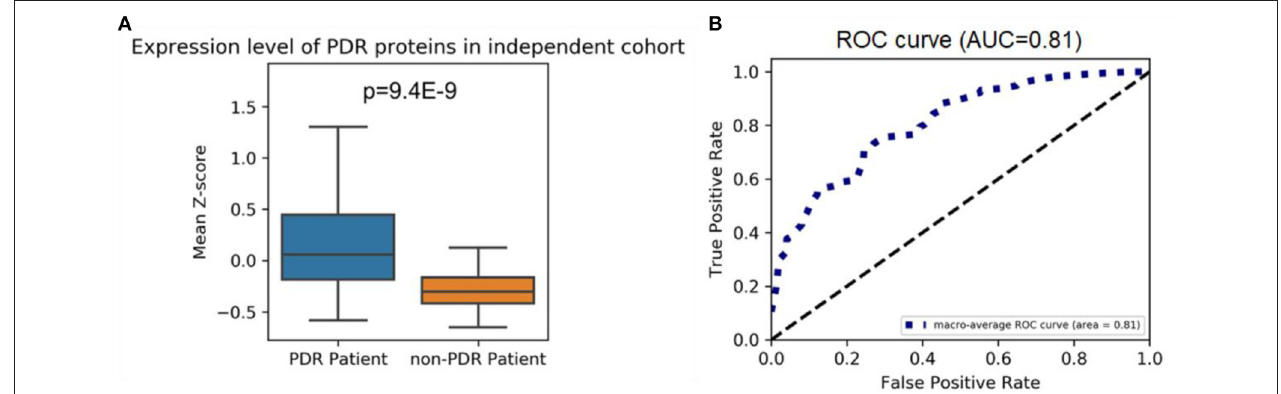
FIGURE 2 | (A) Highly expressed proteome levels in PDR and non-PDR patients from an independent cohort; the mean Z-scores of highly expressed proteins in each patient from two groups were shown. A one-tailed Mann–Whitney U -test was applied to calculate the p -value. (B) ROC curve for the highly expressed proteomes at separating PDR patients from non-PDR patients. ROC curves are plots of the true positive rate (vertical axis) against the false positive rate (horizontal axis) for the different possible cutoff points of a diagnostic test.